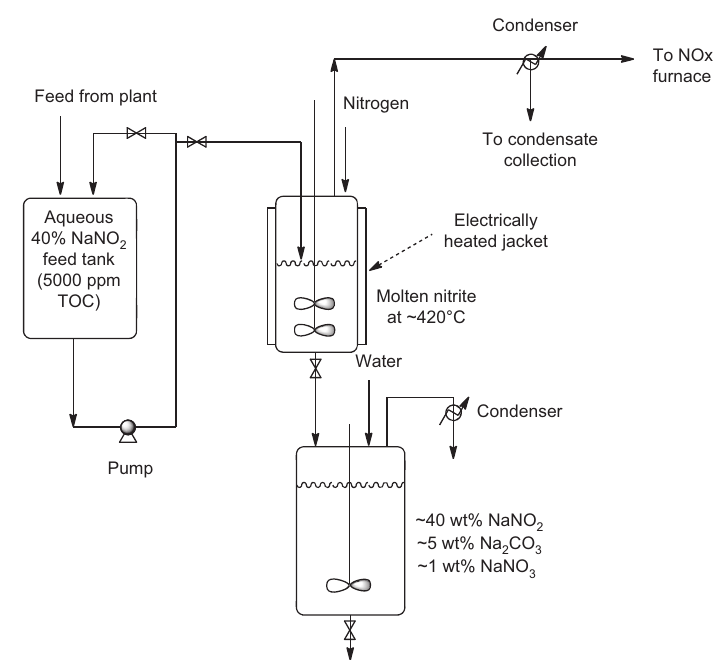
Figure 4 Molten salt oxidation pilot facility to treat contaminated ~40 wt% aqueous NaNO